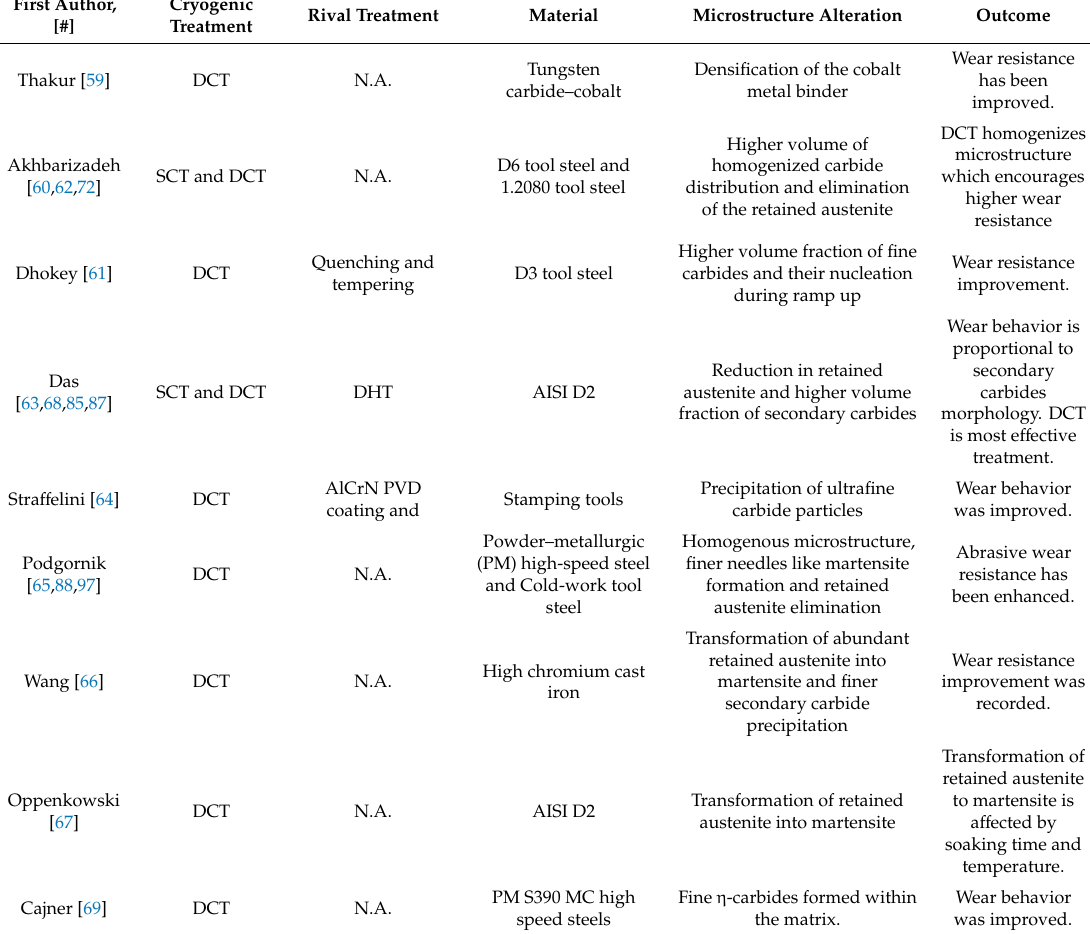
Table 2. Summary of the literature data devoted to studying the e ff ects of cryo-treatment on microstructure and wear